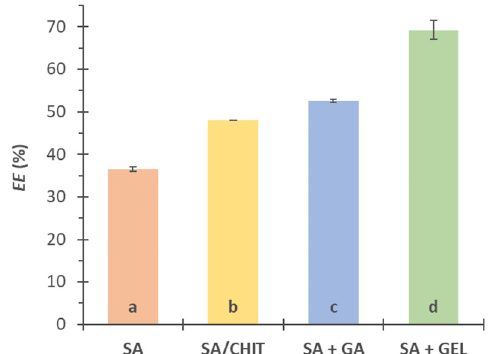
Figure 1. Encapsulation efficiency ( EE , %) of phenol-rich grape pomace extracts using various coatings (3% w/v sodium alginate, SA; combination SA with 1.5% chitosan, SA/CHIT; SA with 1.6% w/v gum arabic, SA + GA; and SA with 5% w/v gelatin, SA + GEL). Different letters represent signi fi cant di ff erences (ANOVA, Duncan’s test at p < 0.05).